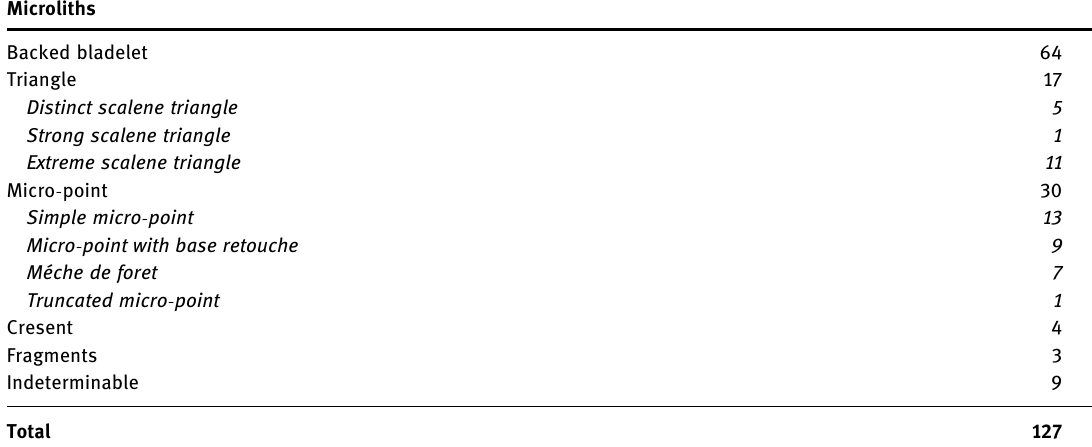
Table 7: Microlith types Schneiderküren